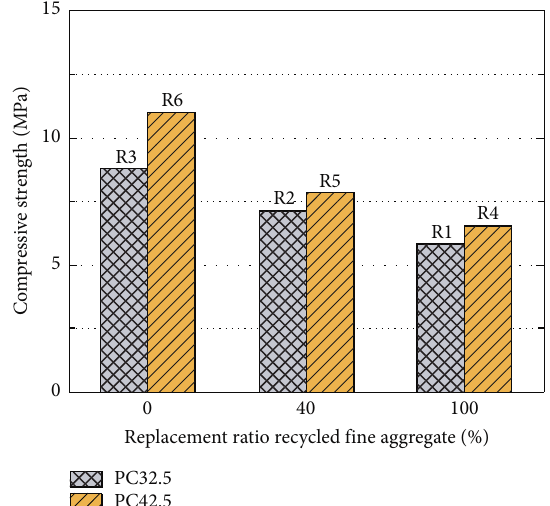
Figure 6: Effect of replacement ratio for recycled fine aggregate on compressive